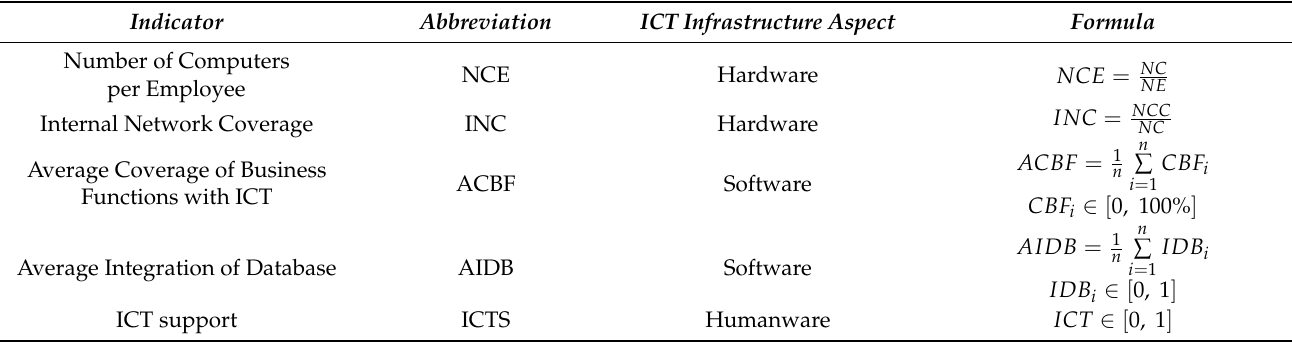
Table 2. ICT infrastructure partial indicators and their